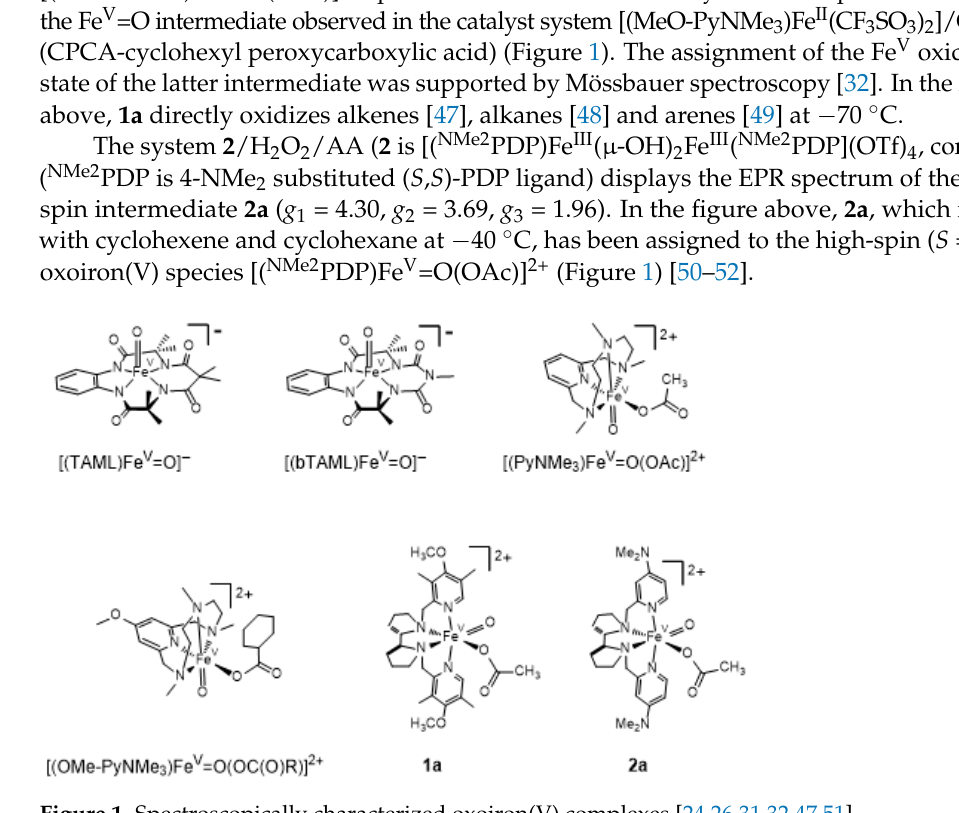
Figure 1. Spectroscopically characterized oxoiron(V) complexes [24,26,31,32,47,51].